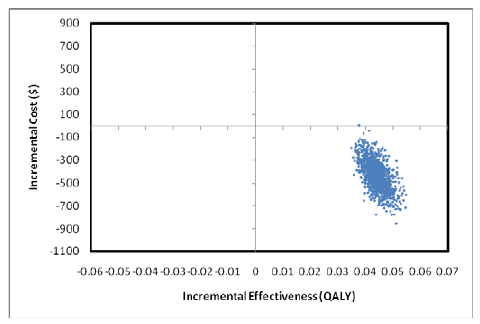
Figure 2. Probabilistic sensitivity analysis. An incremental cost- effectiveness scatterplot comparing FIT-mid with no screening in which the uncertainty in all model inputs has been tested simultaneously. Data points in the lower right quadrant reflect situations where FIT-mid is more effective and less costly than no screening.